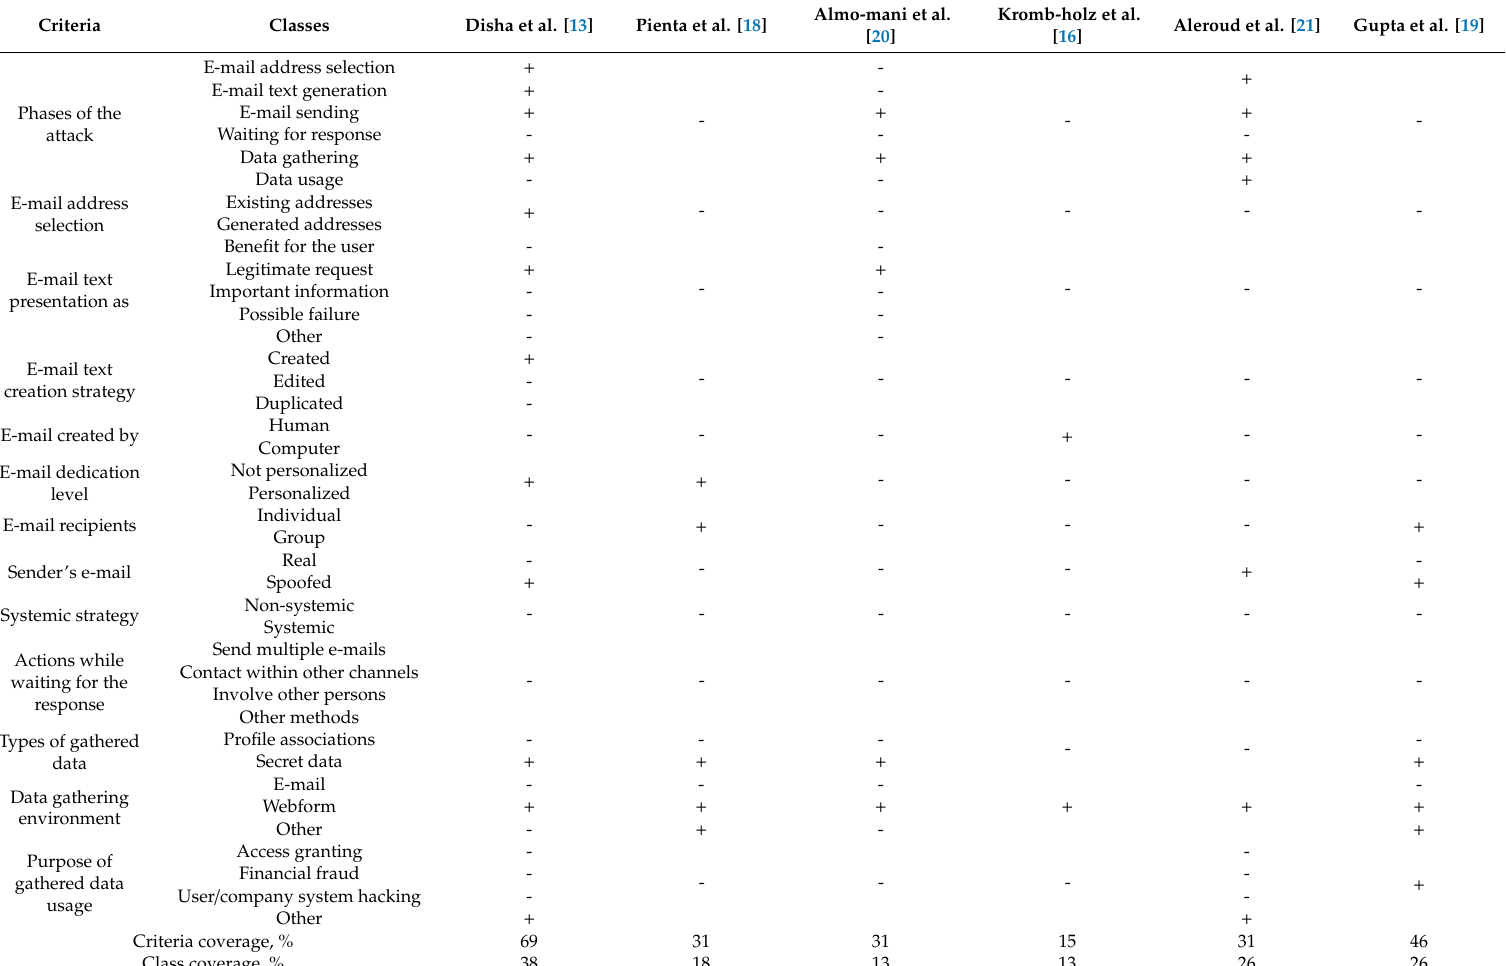
Table 1. Proposed taxonomy content comparison to other related